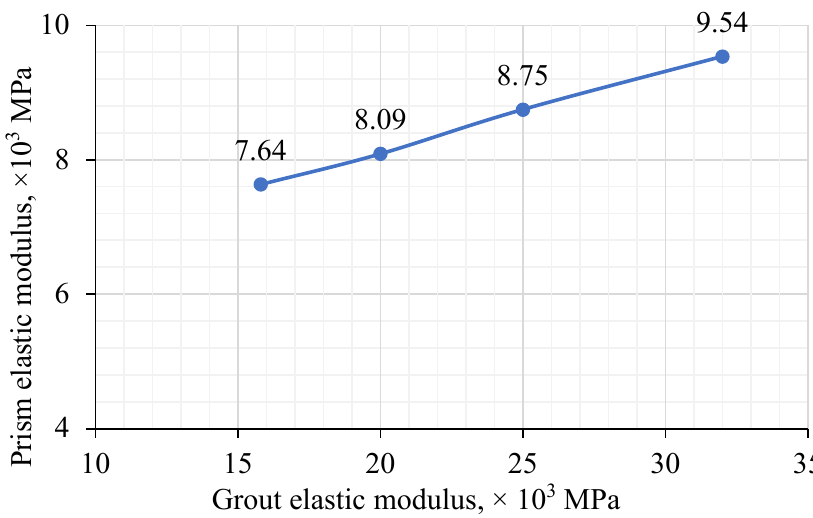
Figure 14. Effect of elastic modulus of grout ( E g ) on elastic modulus of prism ( E p